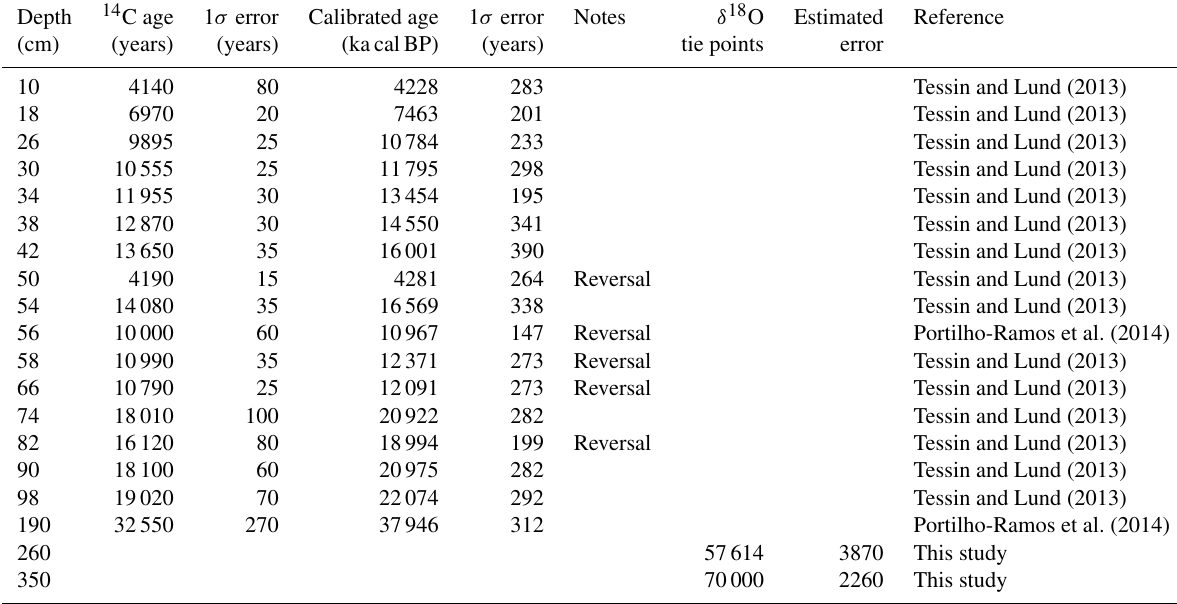
Table 1. Chronology of core JPC-17 obtained by accelerator mass spectrometry (AMS) 14 C dating on planktonic foraminifera shells (Tessin and Lund, 2013; Portilho-Ramos et al., 2014a) and stable oxygen isotope ( δ 18 O) tie points tuned to the LS16 stack from Lisiecki and Stern